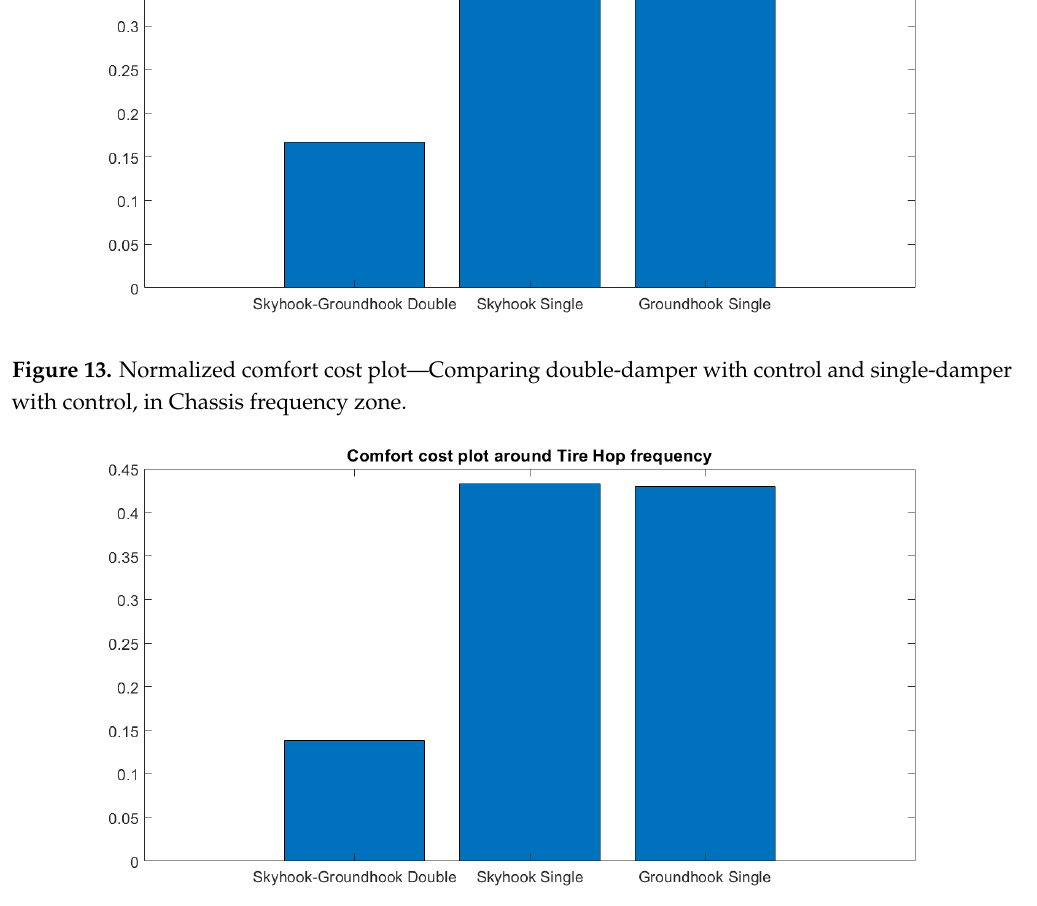
Figure 14. Normalized comfort cost plot—Comparing double-damper with control and single-damper with control, in Tire-hop frequency